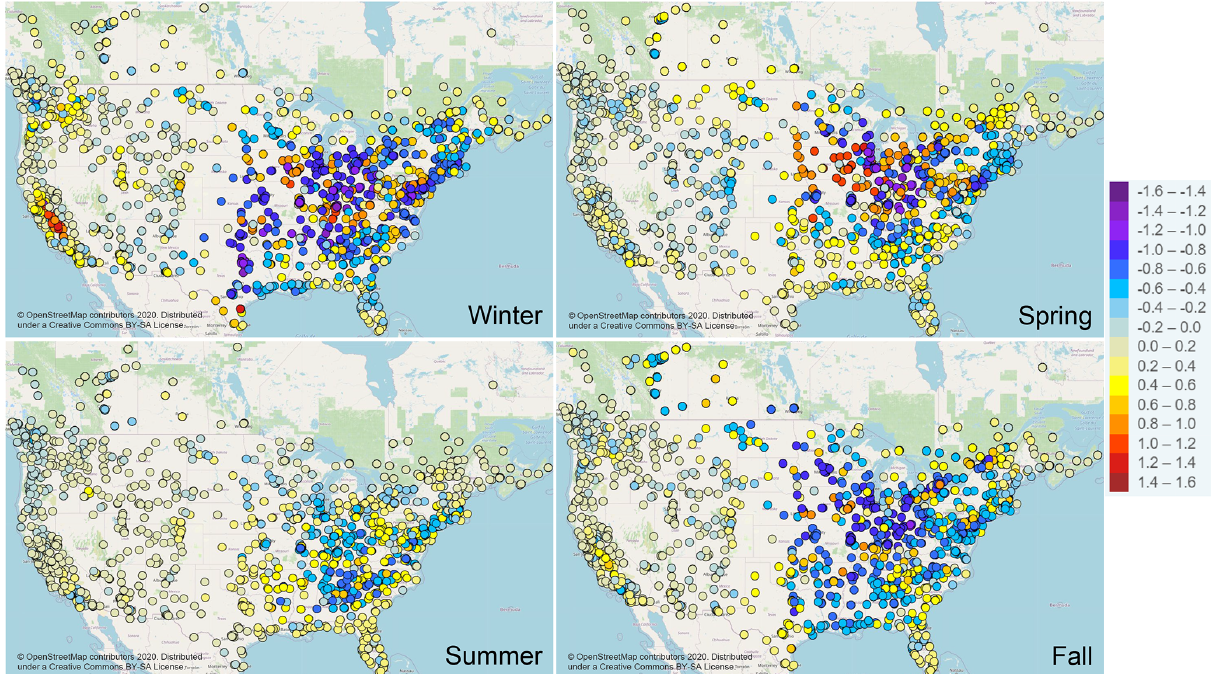
Figure 15. Seasonal average PM 2 . 5 absolute bias difference (µgm − 3 ) between CMAQ531_WRF411_M3Dry_BiDi and CMAQ531_WRF411_STAGE_BiDi simulations for all AQS and NAPS sites to highlight the impact of the M3Dry and STAGE de- position models. Cool shading (negative values) indicates smaller bias in the CMAQ531_WRF411_M3Dry_BiDi simulation, and warm colors (positive values) indicate smaller bias in the CMAQ531_WRF411_STAGE_BiDi simulation.